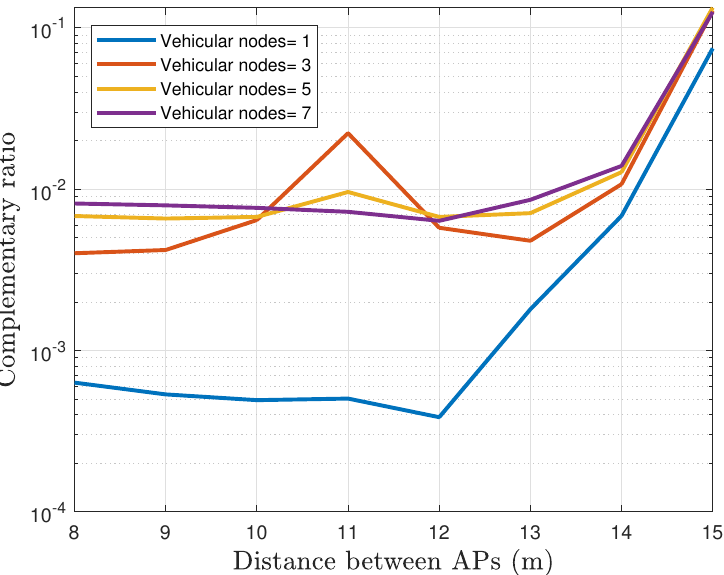
Figure 21. The complement of the service availability for different number of vehicular nodes operating in the network (Outage